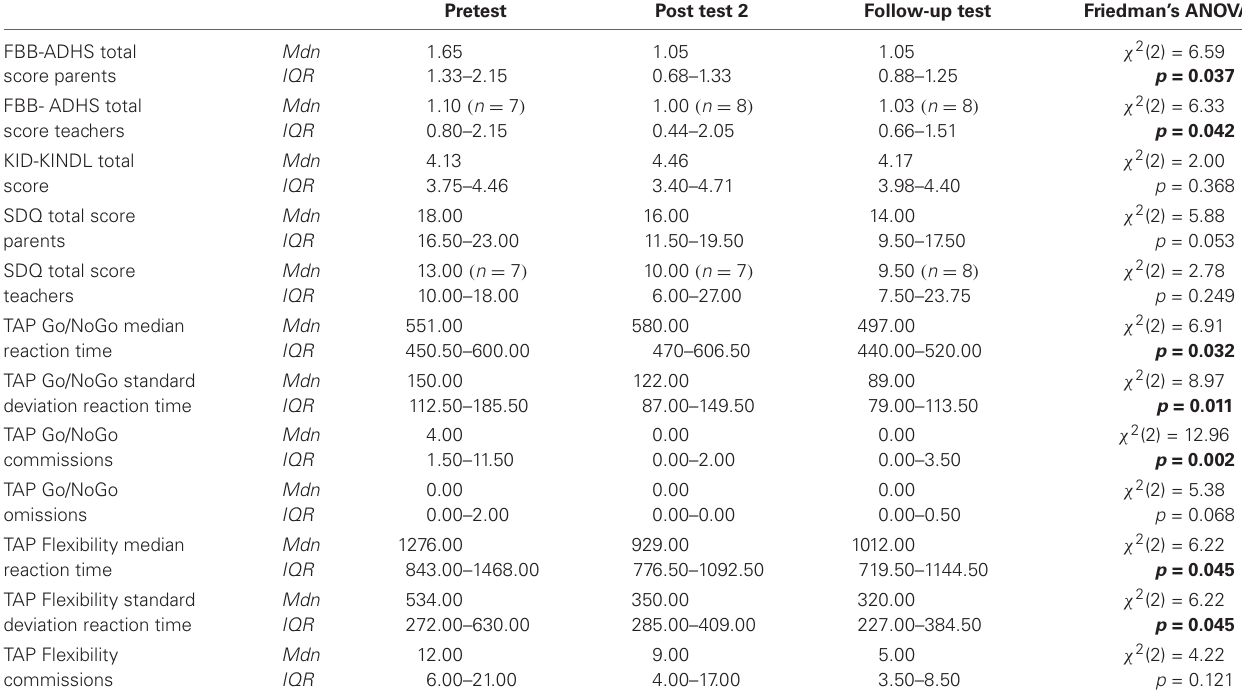
Table 3 | Medians and interquartile ranges for the dependent variables of the NIRS-group at all measurement points with test statistics . Pretest Post test 2